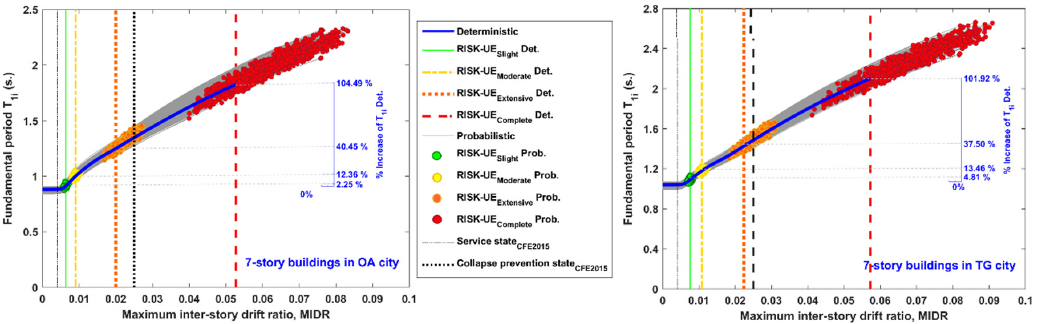
Figure 9. Deterministic and probabilistic T 1i –MIDR relationship curves of the 7-story buildings in OA and TG cities and their respective DS non-null .